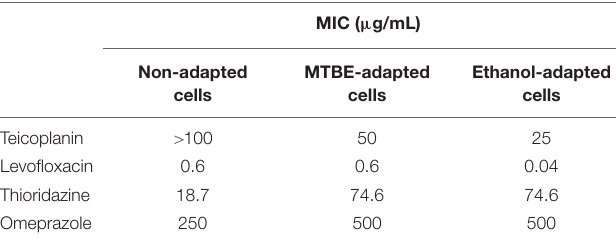
TABLE 1 | Minimum inhibitory concentration (MIC) of the antibiotics teicoplanin and levofloxacin and of the efflux pump inhibitors (EPIs) thioridazine